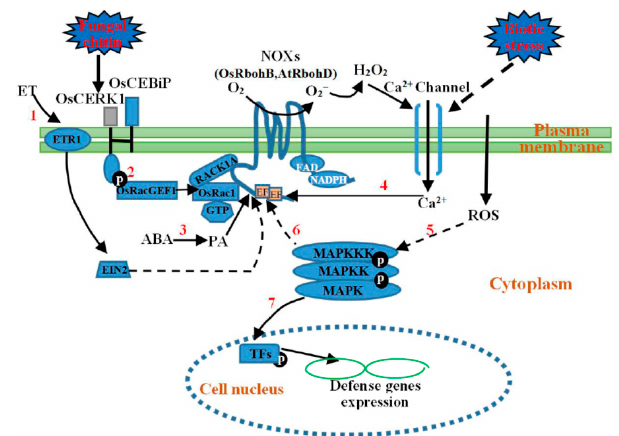
Figure 3. Phosphorylation-independent regulation of NOXs during plant immunity. ( 1 ) ET (ethylene) receptor 1 (ETR1)-and ethylene insensitive 2 (EIN2)-mediated signaling also activates AtRbohD; ( 2 ) Upon PAMP perception, PRRs in rice, such as chitin elicitor-binding protein (OsCEBiP) and OsCERK1, function as the receptor complex. OsCERK1 directly phosphorylates and activates OsRacGEF1, leading to GTP binding to OsRac1; at the same time, OsRac1 also interacts with the N-terminus of the OsRbohB directly or via the RACK1A (receptor for activated C-kinase 1 A) protein; ( 3 ) ABA induces the production of PA (phosphatidic acid), which binds to and activates AtRbohD; ( 4 ) Cytosolic Ca 2+ binds to EF-hand motifs of NOXs, which leads to activation of NOXs. The produced H 2 O 2 itself may trigger further activation of Ca 2+ channel(s); ( 5 – 7 ), MAPK cascades serve as positive regulators of NOXs and produced ROS also activates MAPK cascades, ending in MAPK cascades activating or inhibiting some transcription factors (TFs) by phosphorylation to induce defense gene expression. The solid lines and dashed lines represent determinate and potential interactions,